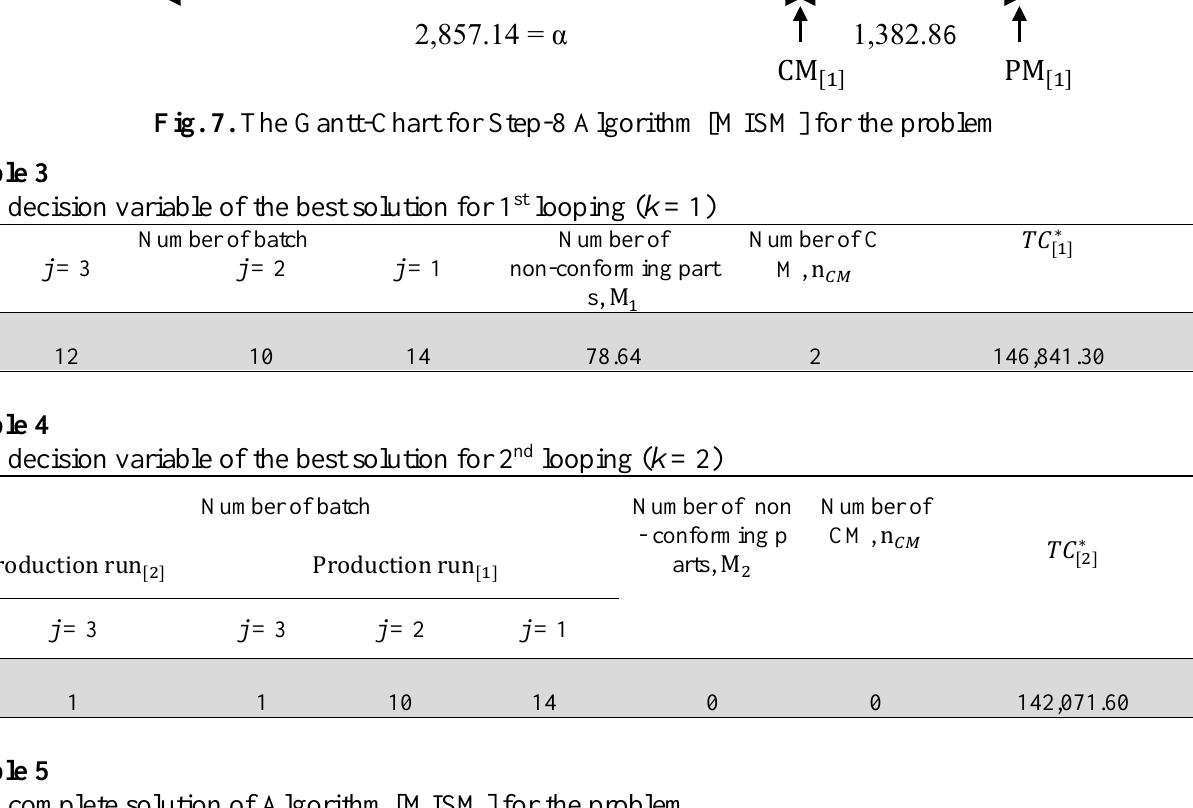
The complete solution of Algorithm [MISM] for the problem Batch size